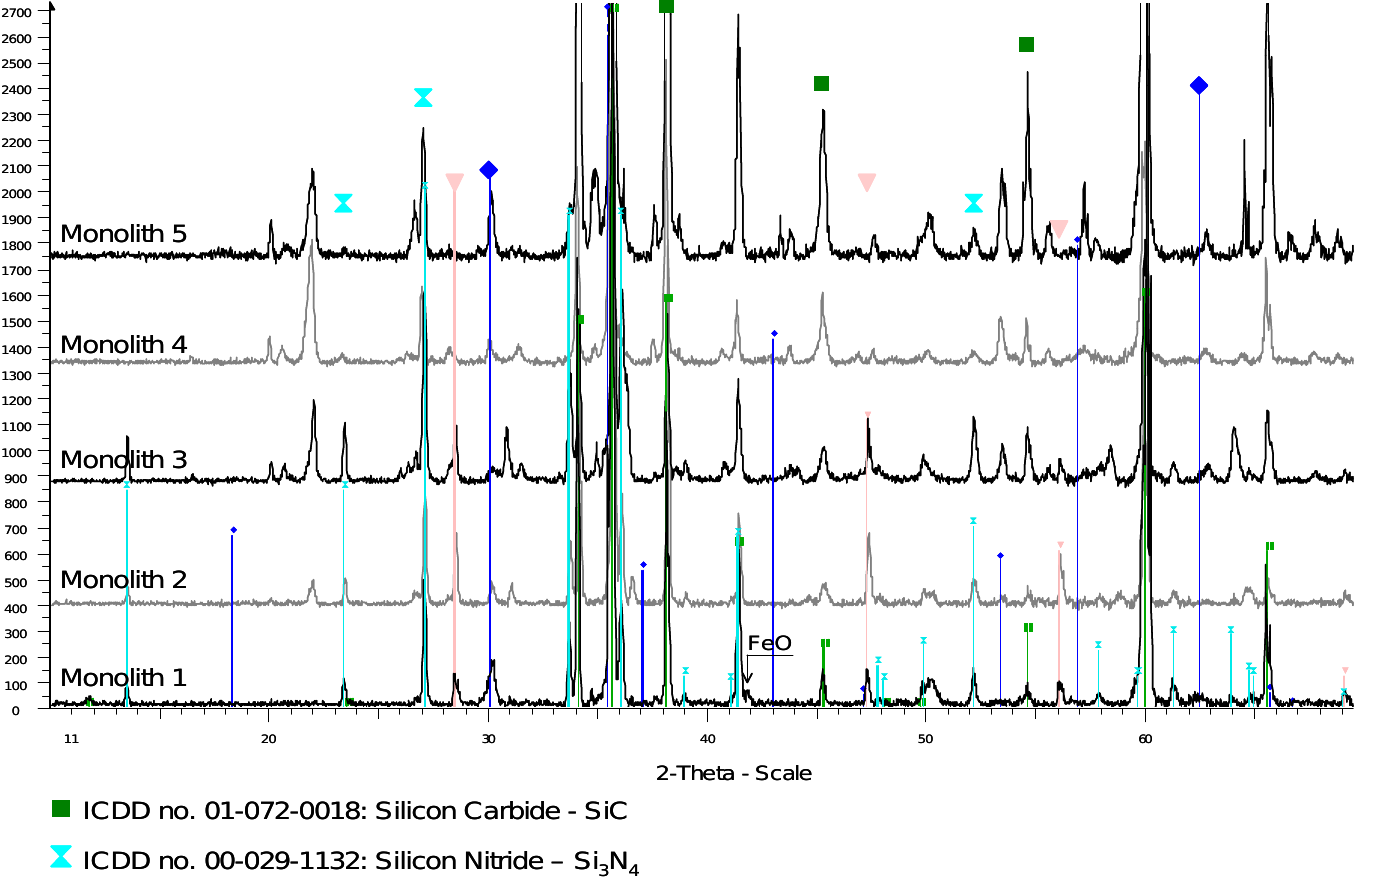
N , Si and Fe O 3 4 3 4